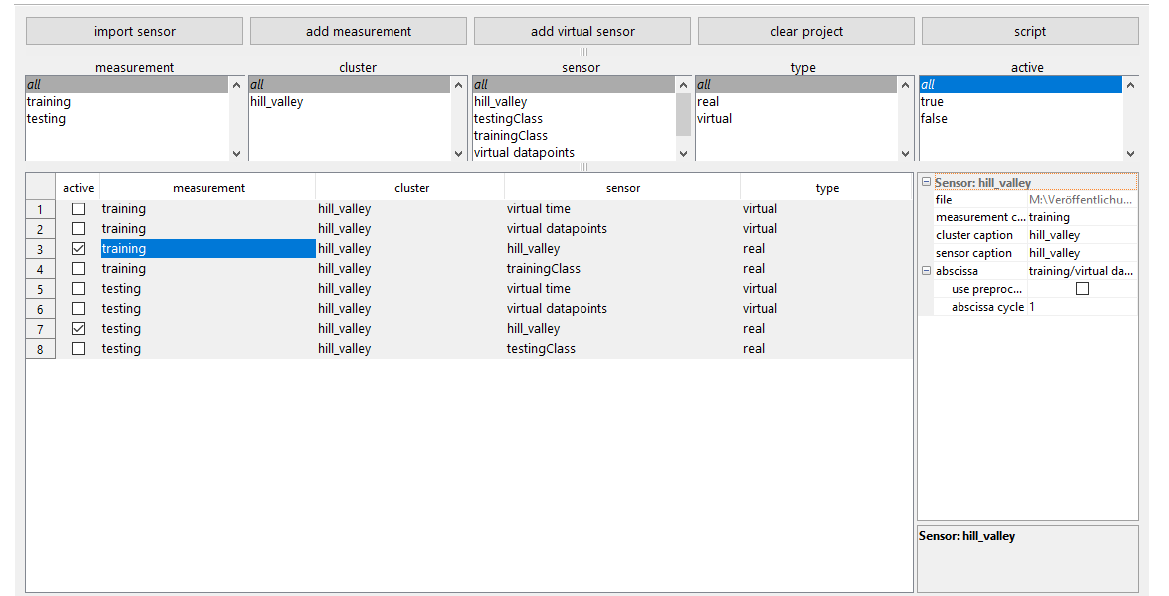
Figure 4. Data import module with two measurements. All available sensors are listed in the table which can be filtered with the list boxes above. Properties of the currently selected measurement, cluster, and sensor can be edited in the PropertyTable on the right.